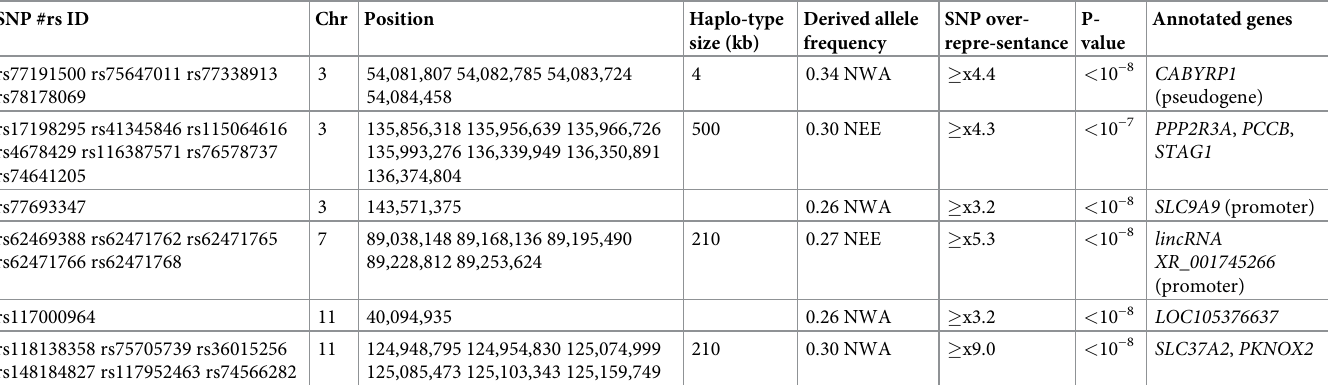
Table 4. Six loci with the strongest signals for positive selection in North Eurasia populations identified by whole-genome allele frequency analysis � .